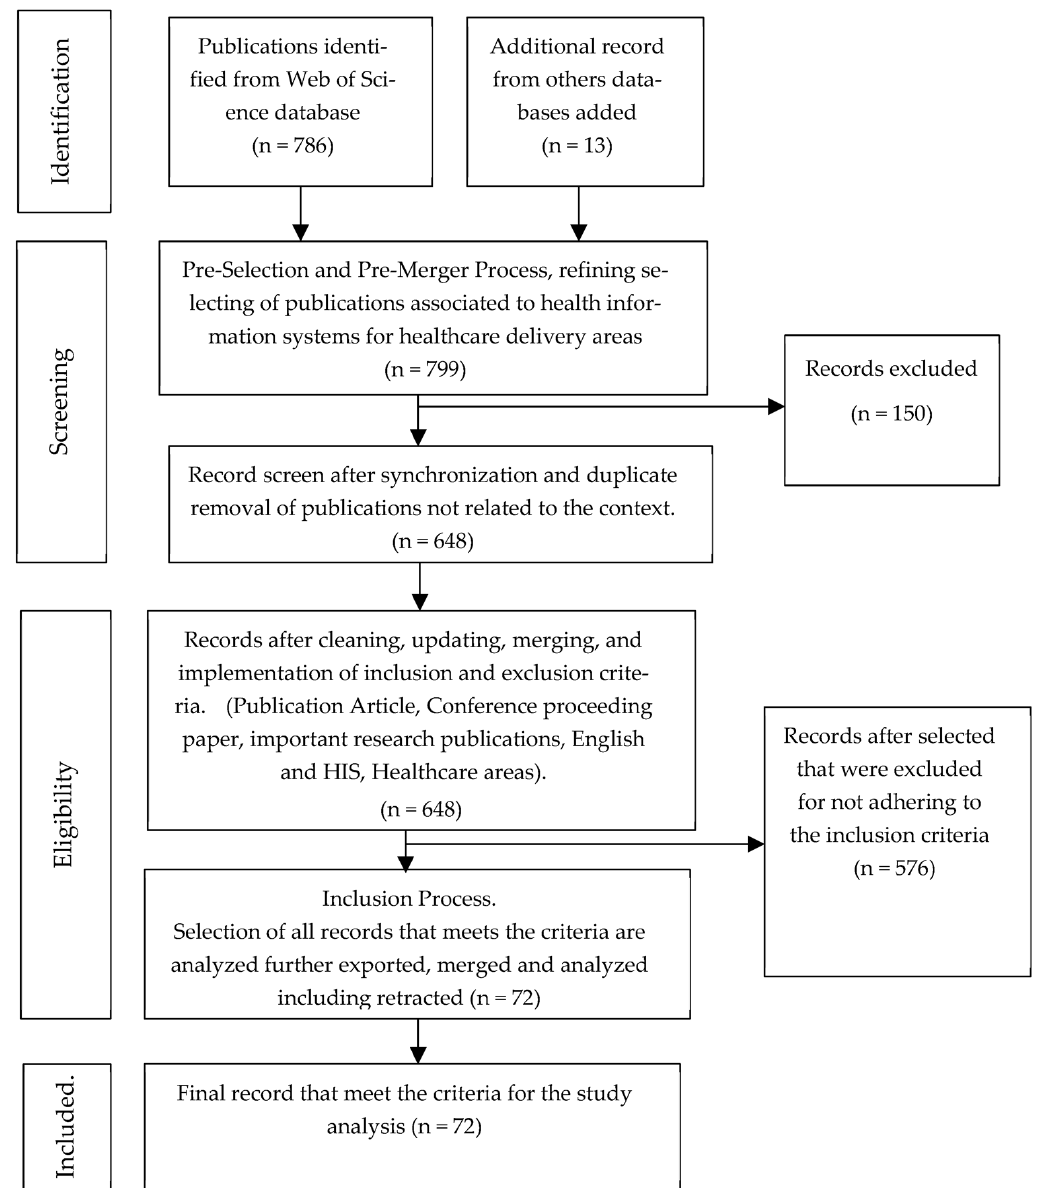
Figure 1. Prisma flow Statement.